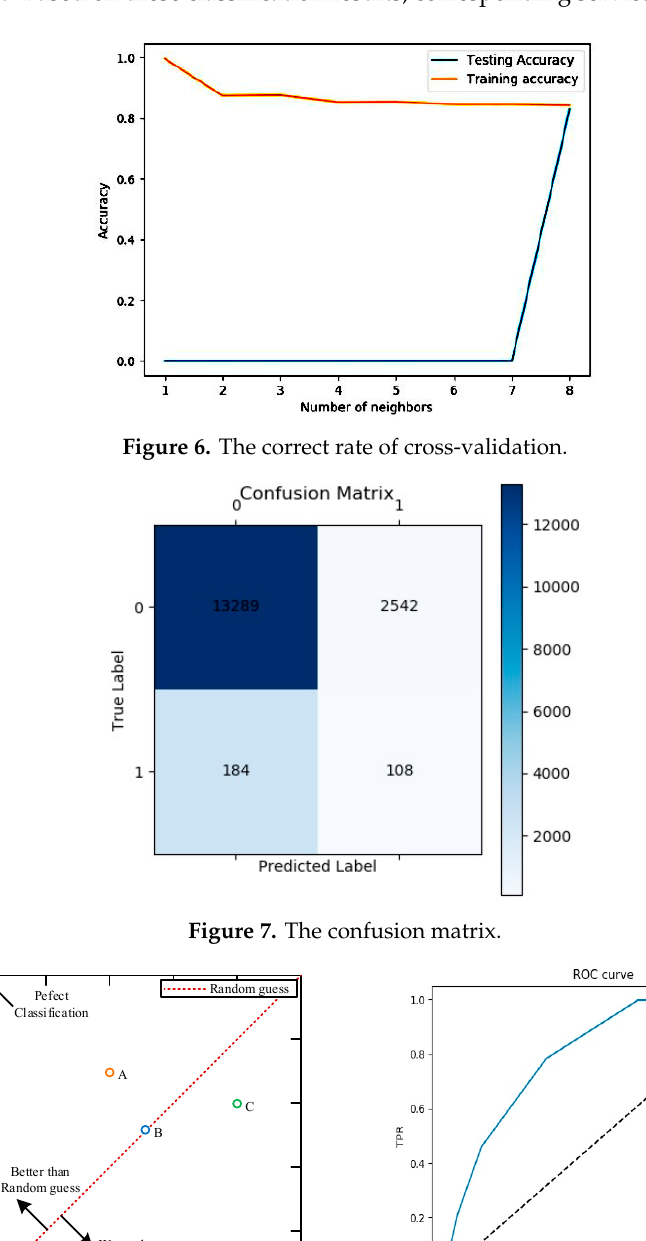
Figure 7. The confusion matrix.